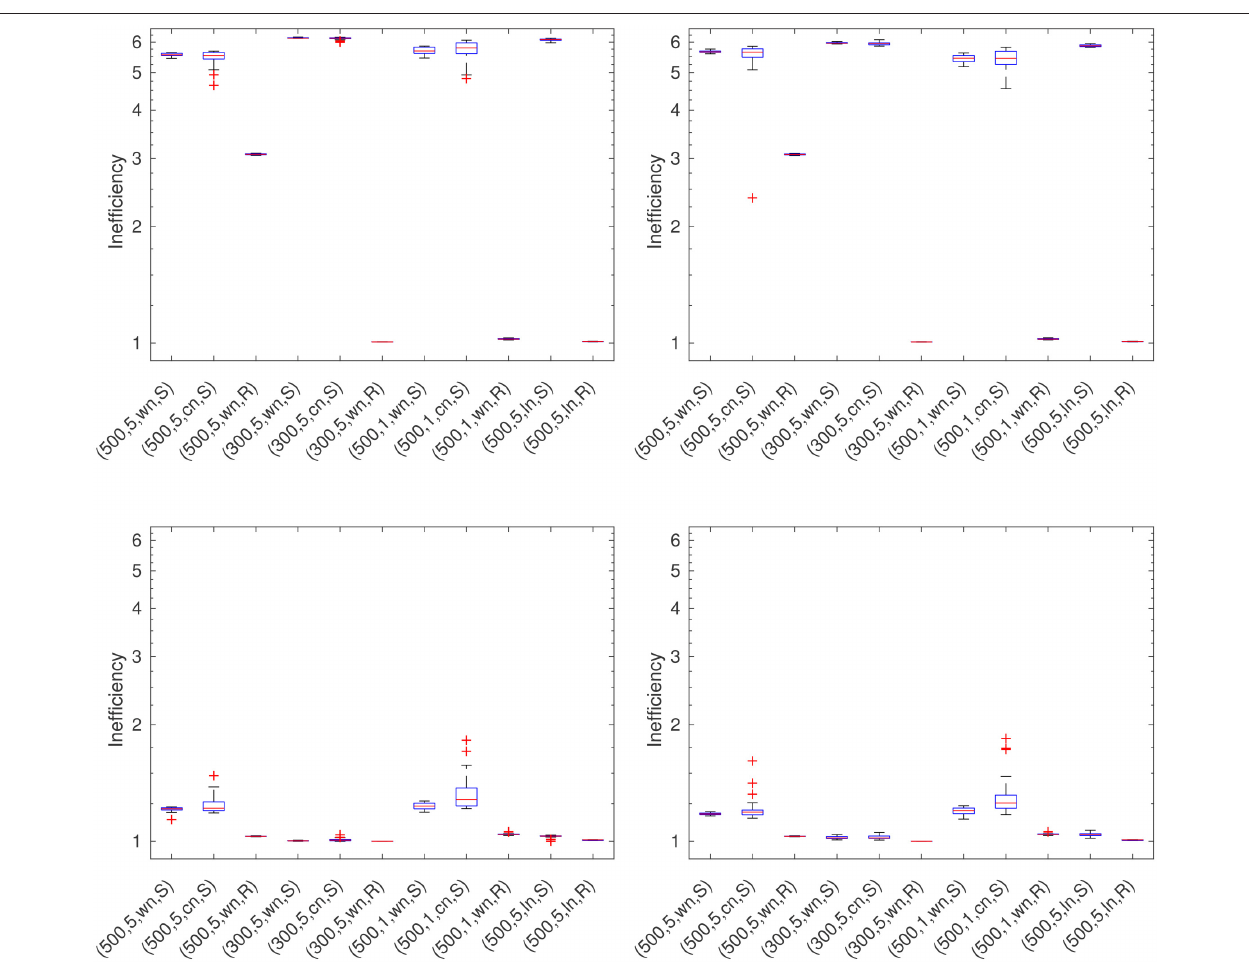
FIGURE 5 | QOC for the RFMP (Left-hand top) and the ROFMP (Right-hand top) and LC for the RFMP (Left-hand bottom) and the ROFMP (Right-hand bottom) .